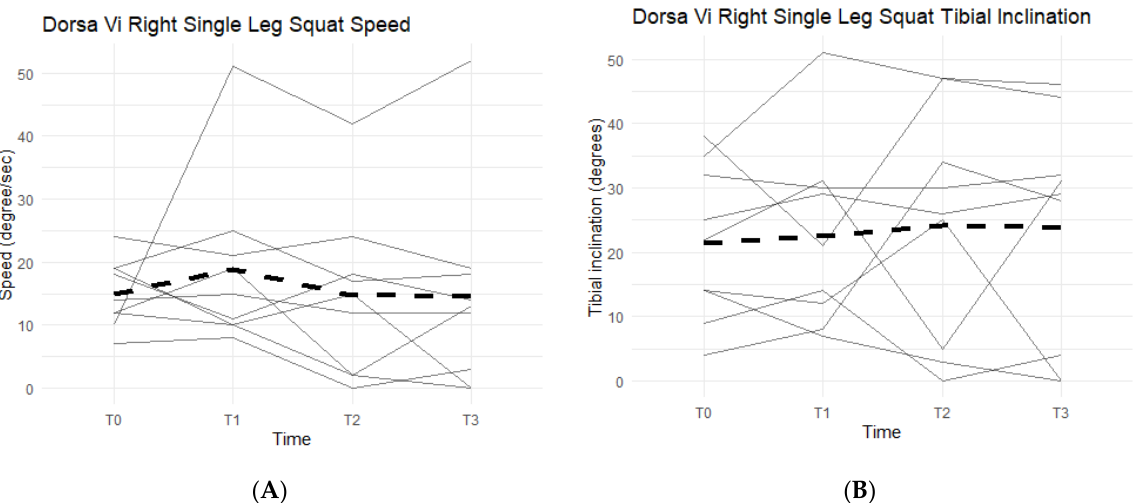
Figure 15. Right Single ‐ Leg Squat Changes Over Time. Changes in single ‐ leg squat scores, speed, and tibial inclination were graphed to compare results at T0, T1, T2, and T3. ( A ) graphs speed measured in degrees per second as a function of time. ( B ) graphs tibial inclination in degrees as a function of time. Solid lines represent individual data, dashed lines are group averages.